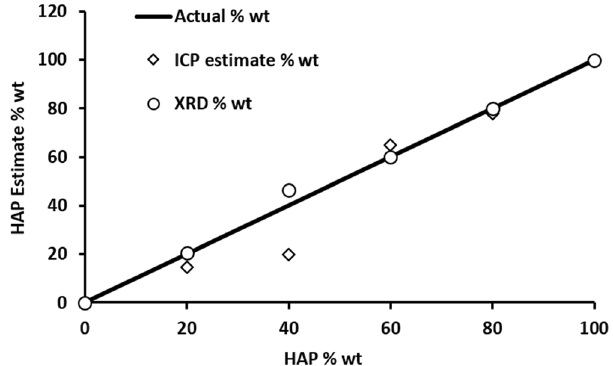
Figure 5. Exact percentage of HAP present in standards plotted against the measured percentage from the different analytical techniques employed: ICP and